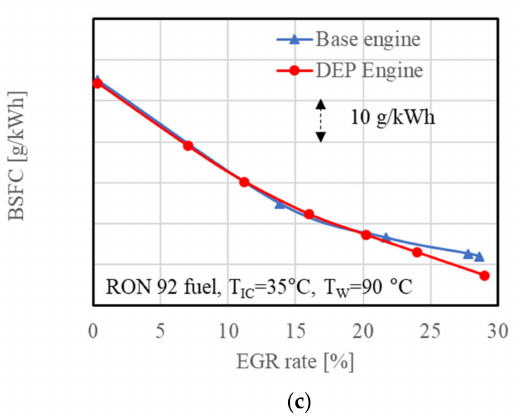
Figure 13. Synergistic effect between DEP and high diluted combustion: ( a ) Exhaust pressure; ( b ) PMEP; ( c ) BSFC.